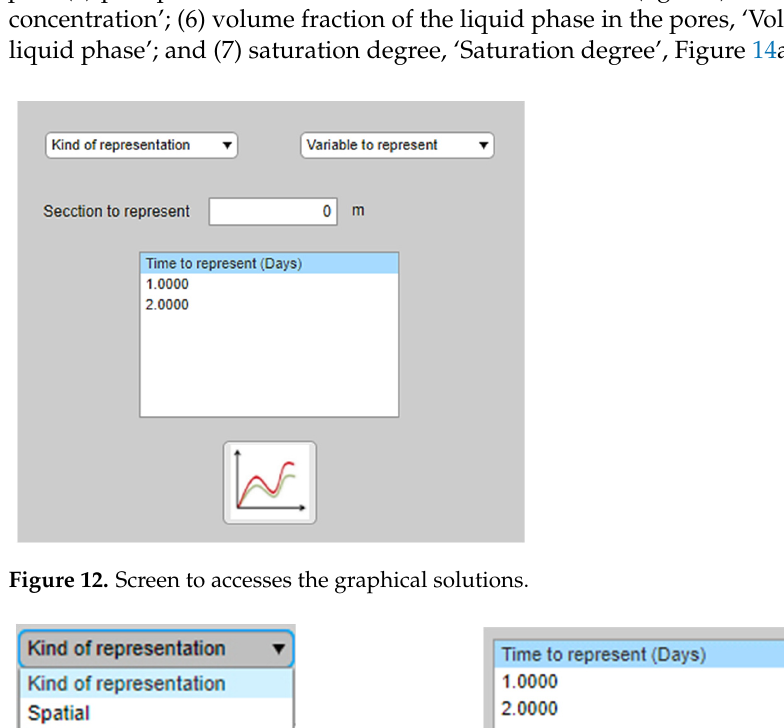
Figure 11. Auxiliary screen to show the simulation number in process (the eighth day of the 365 planned).